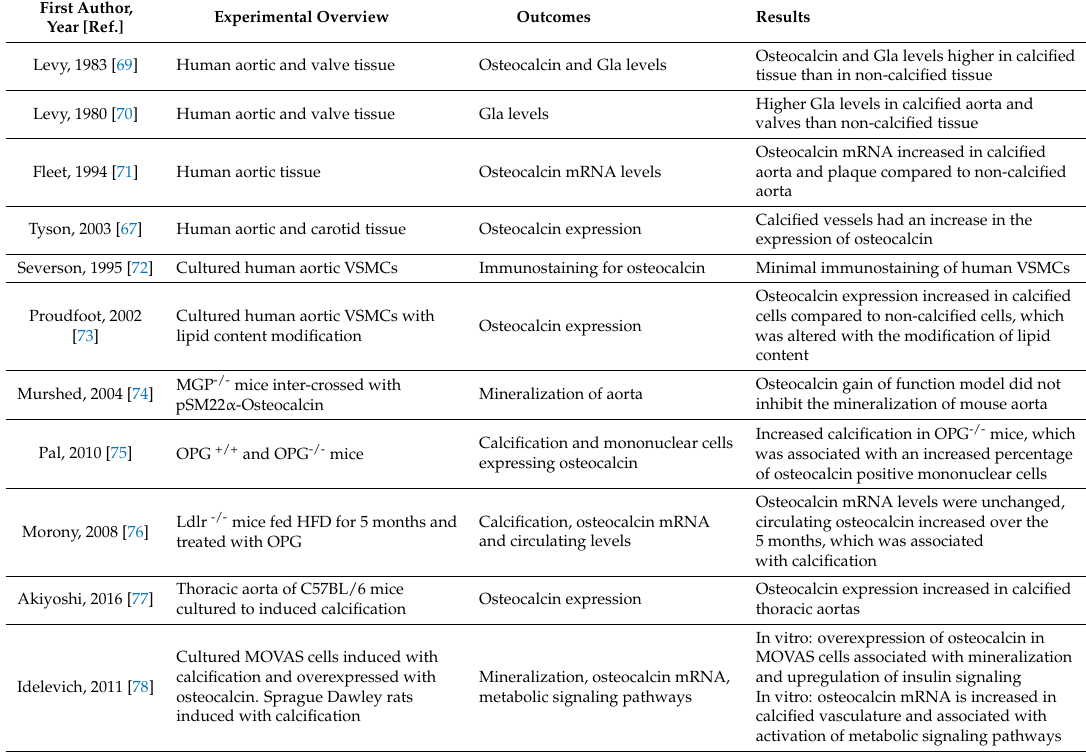
Table 3. Summary of studies examining the interaction between osteocalcin and calcification in human and animal tissue and